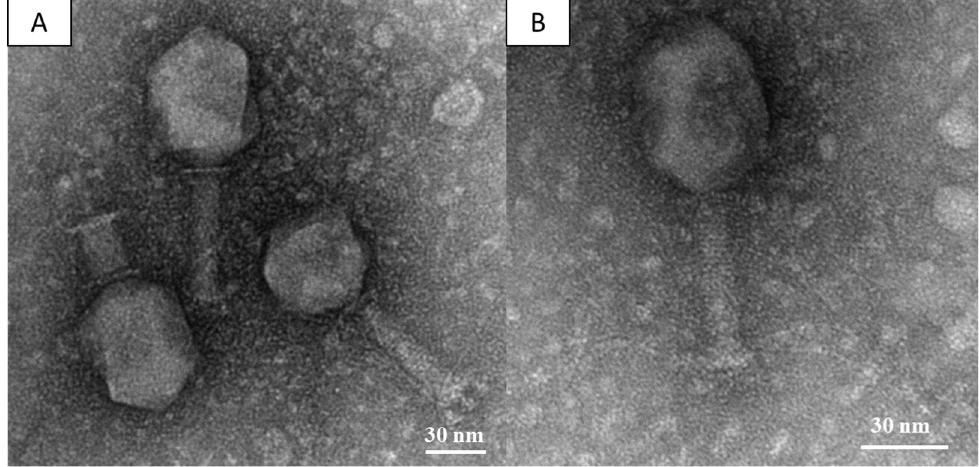
Figure 1. ( A , B ) Electron micrograph of phage vB_Kpn_F48 negatively stained with uranyl acetate. Bars indicate 30 nm.